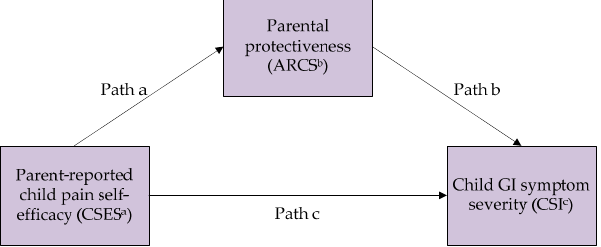
Figure 1. Mediation model 1—Parent ‐ perceived child pain self ‐ efficacy, parental protectiveness, and parent ‐ reported child gastrointestinal (GI) symptom severity. a CSES: Child Self ‐ Efficacy Scale; b ARCS: Adult Responses to Children’s Symptoms—Protectiveness subscale; c CSI: Children’s Somatization Inventory—GI subscale.